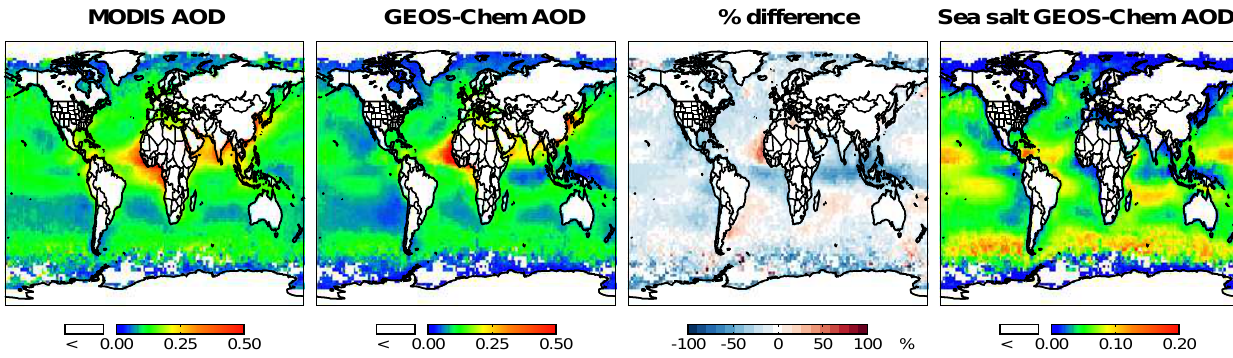
Fig. 3. Annual average aerosol optical depth (AOD) at 550 nm in 2007 for MODIS, GEOS-Chem, % difference (GEOS-Chem-MODIS) and sea salt component of GEOS-Chem. Model was sampled at the time and location of MODIS overpass. Table 1. Summary of modeled and measured aerosol concentrations by campaign. All units (µgm − 3 ) a